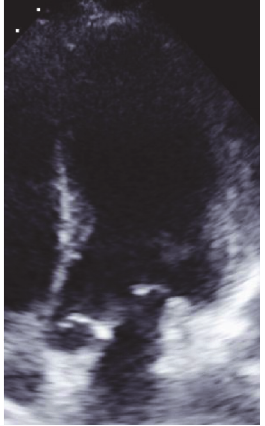
Figure 8: Resolution of SIC, end diastole (SIC resolution